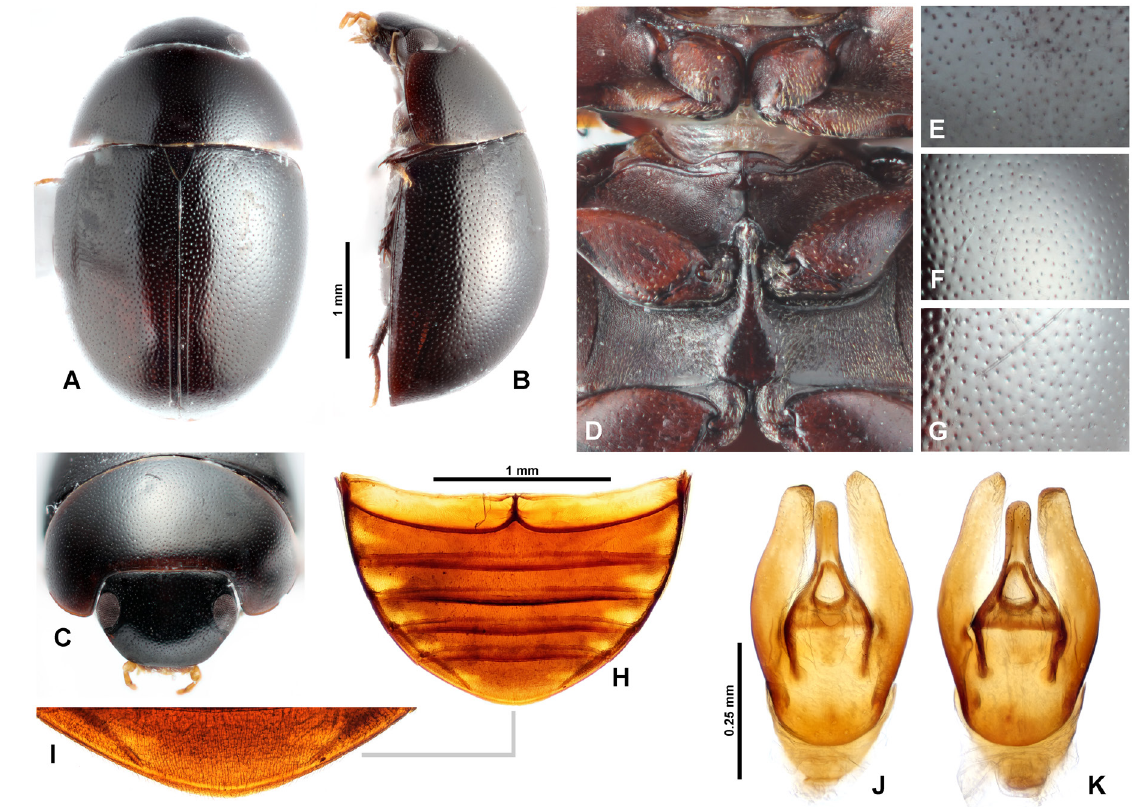
Fig. 8. Coelostoma (s. str.) vividum Orchymont, 1936, specimens from Assam: Kohora (NMPC). A . Dorsal habitus. B . Lateral habitus. C . Frontal view. D . Thorax in ventral view. E . Dorsal punctation of head. F . Dorsal punctation of pronotum. G . Dorsal punctation of elytron. H . Abdominal ventrites. I . Detail of abdominal apex. J–K . Aedeagus: dorsal (J) and ventral